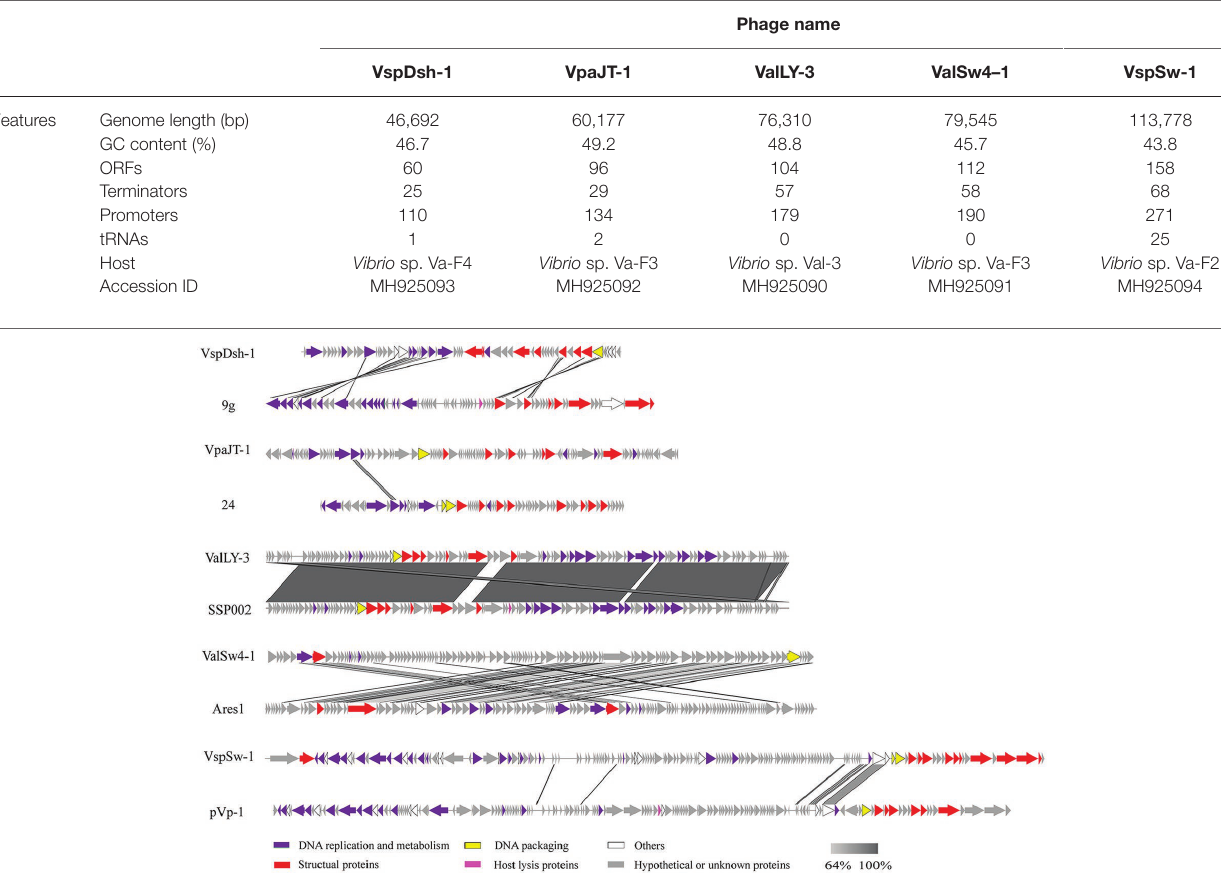
TABLE 1 | Genomic features of the five phages.